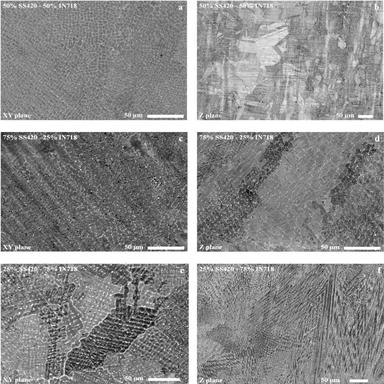
Microstructures of mixed composition DED specimens, a) 50% SS420–50% IN718 XY plane, b) 50% SS420–50% IN718 Z plane, c) 75% SS420–25% IN718 XY plane, d) 75% SS420–25% IN718 Z plane, e) 25% SS420–75% IN718 XY plane, f) 25% SS420–75% IN718 Z plane.